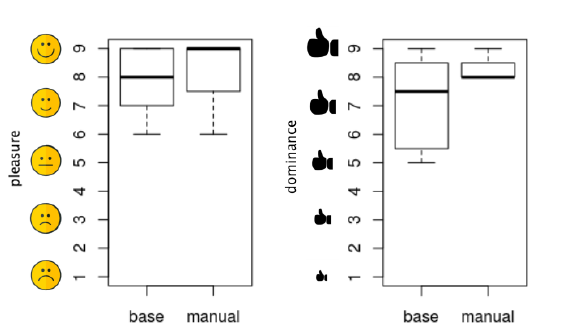
Fig. 2. Boxplots of pleasure and dominance indexes -